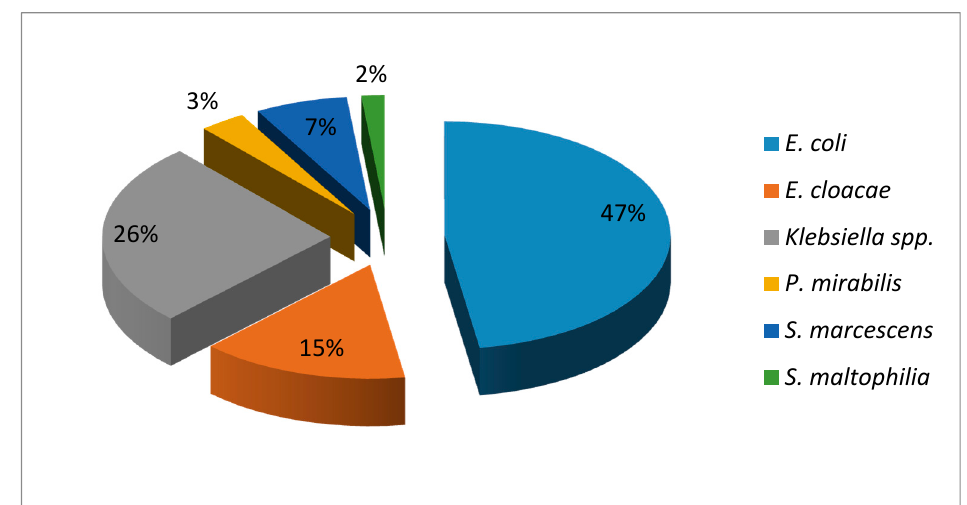
Figure 3. Distribution of species of Gram-negative bacilli causing neonatal infections Havana, 2017–2018. Figure 4 shows resistance rates to β -lactam antimicrobials of different bacterial species. Except for P. mirabilis , four Gram-negative species showed high resistance rates to penicillin (>59%) and ceftriaxone (31–75%).